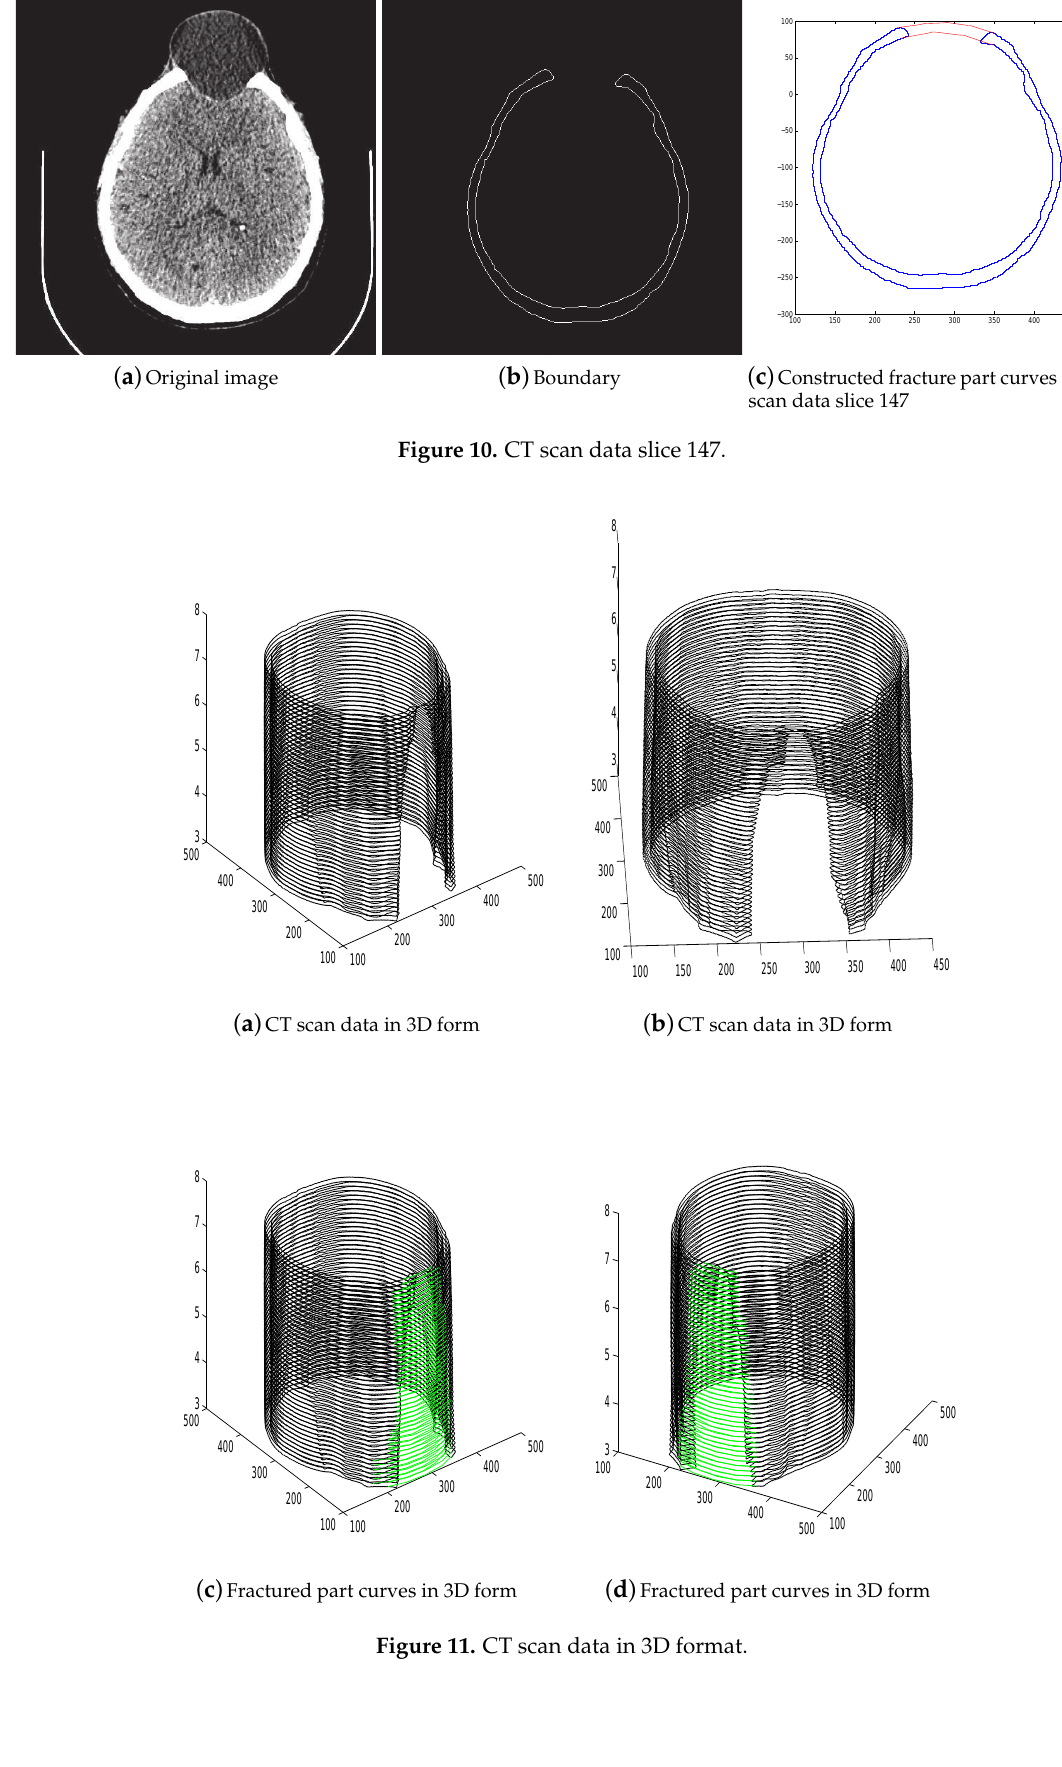
Figure 11. CT scan data in 3D